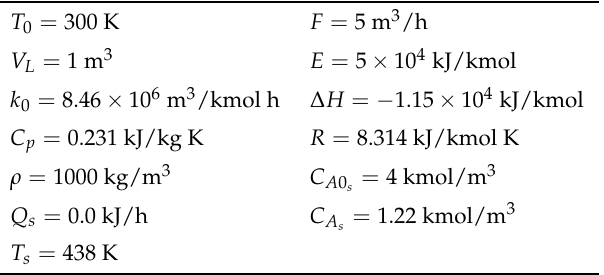
Table 1. Parameter values of the continuous stirred tank reactor